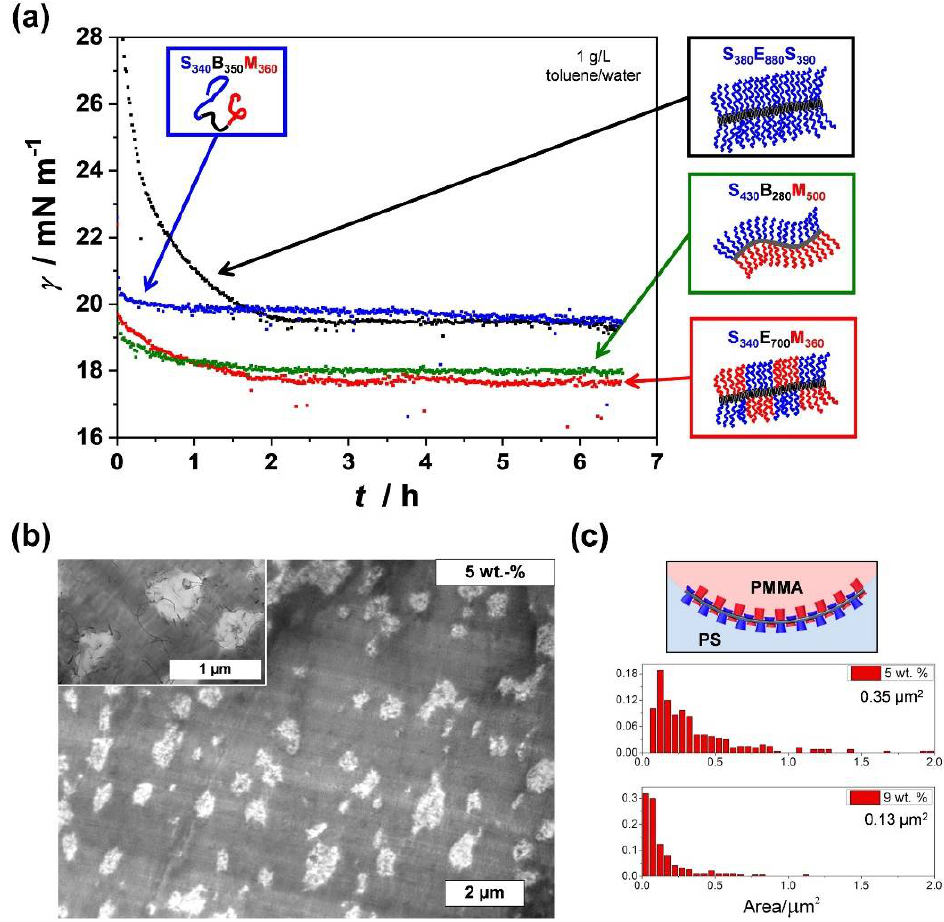
Figure 9. ( a ) Comparison of interfacial tension isotherms of 1 g∙L −1 solutions containing SBM unimers, SES wCCMs with a homogeneous PS corona, SEM wCCMs with a patchy PS/PMMA corona, and SBM-based Janus cylinders with opposing PS and PMMA faces (given subscripts corre- spond to average degrees of polymerization of the respective blocks). ( b ) TEM image of a solvent-cast PS/PMMA blend (80/20 w / w ) compatibilized with 5 wt. %. patchy CNTs (PS/PMMA corona). ( c ) Schematic representation of the adaption of the patchy PS/PMMA corona to the PS/PMMA blend interface by selective collapse/expansion of the incompatible/compatible corona blocks (top) and histograms of PMMA domain areas for blends with 5 wt. %. and 9 wt. %. patchy CNTs (bottom). ( a ) Reproduced from [159] with permission of Elsevier and ( b , c ) reproduced from [162] with permis- sion of ACS.